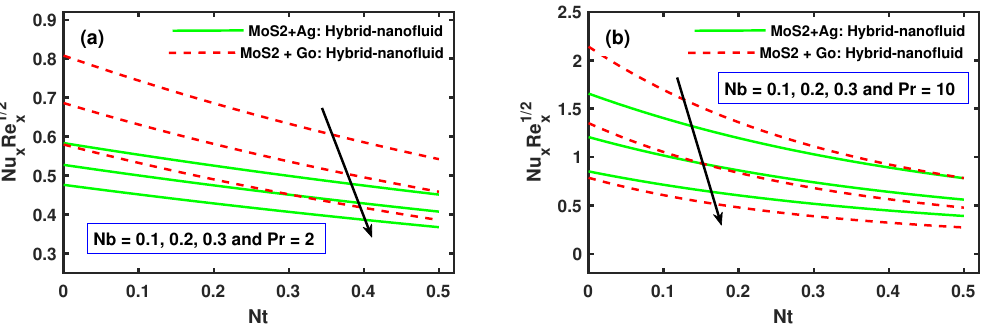
Figure 14. Fluctuation of Nu x Re 1/2 x along with Nb, Nt (thermophoresis), and Pr (Prandtl number) at ζ =